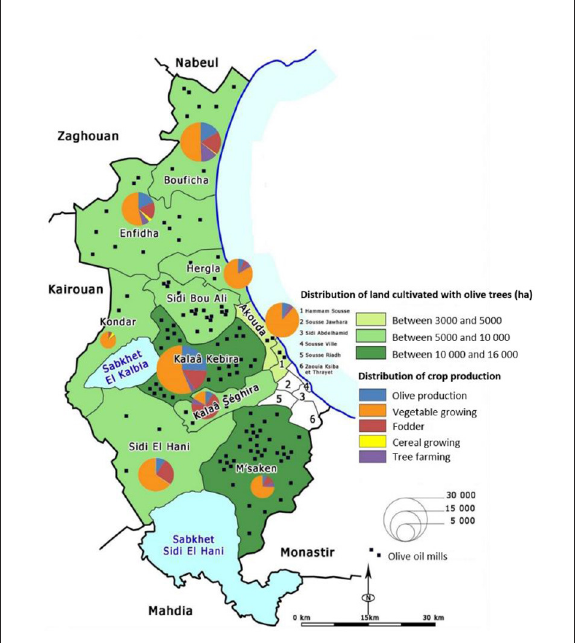
FIGURE5 Distribution of agricultural lands and croplands in the urban agglomeration of Sousse. Source: CRDA (2018).